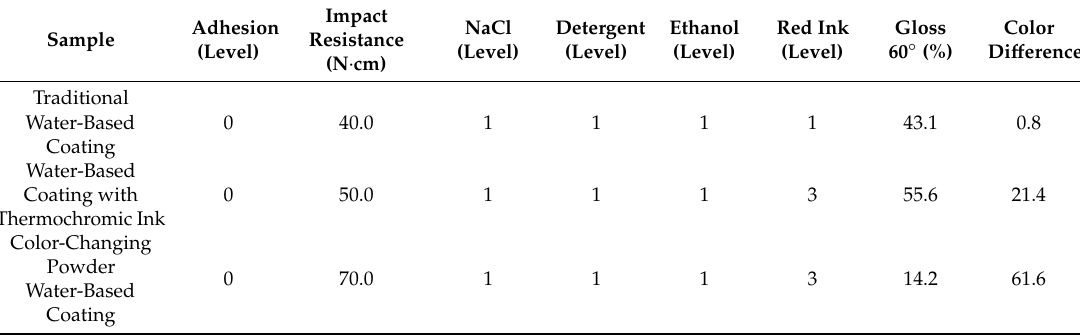
Table 11. Performance comparison of the color-changing powder water-based coating with the traditional water-based coating and waterborne coating with thermochromic